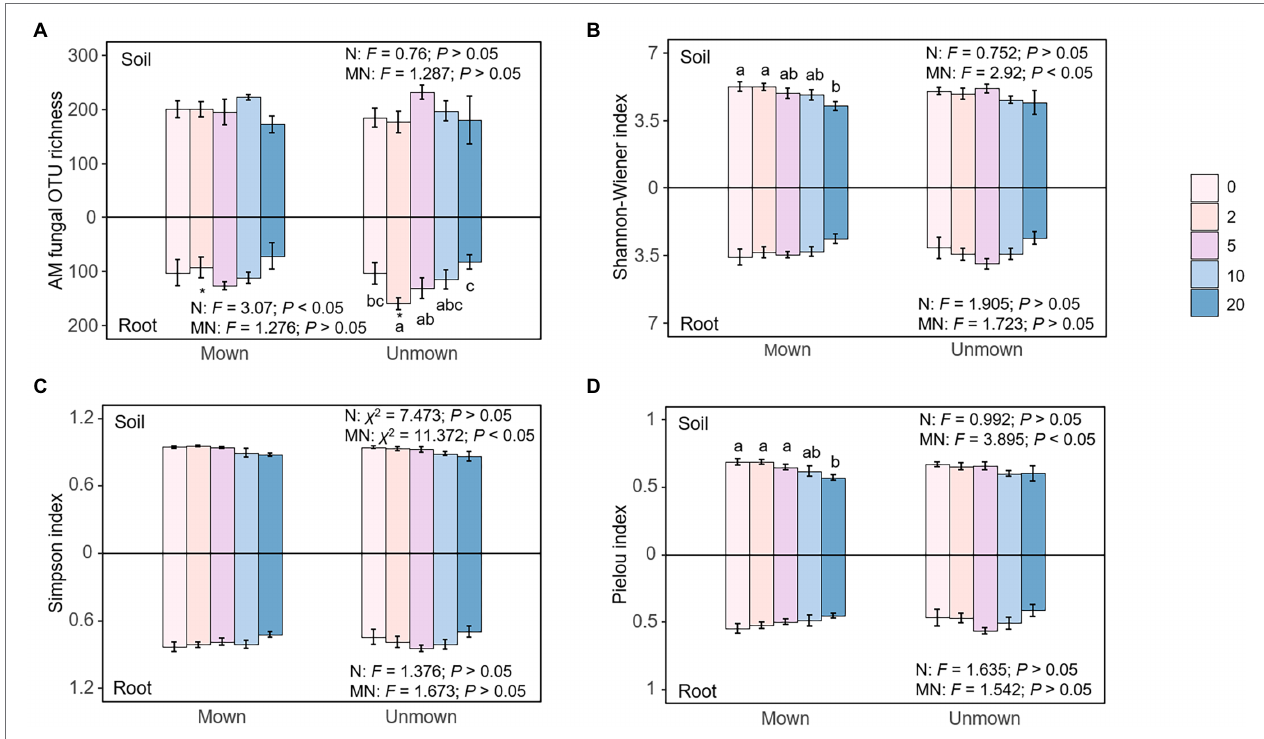
FIGURE 2 | Effects of nitrogen addition (N) and mowing (M) on AM fungal α -diversity in soil (upper) and roots (lower): (A) AM fungal operational taxonomic unit (OTU) richness, (B) AM fungal Shannon-Wiener index, (C) AM fungal Simpson index, (D) AM fungal Pielou index. All data are expressed as mean ± SE ( n = 5). One- way ANOVA, Tukey’s HSD, and t tests were used to test the effects of nitrogen addition and mowing on AM fungal α -diversity in the soil and roots in each nitrogen addition and mowing treatment. Different letters denote significant differences ( p < 0.05) among nitrogen addition rates in the mown and unmown treatments at soil or root. The symbol “*” at the top or bottom of the column indicates a significant difference ( p < 0.05) between mown and unmown at each nitrogen addition rate in soil or root. The numbers 0, 2, 5, 10, and 20 denote nitrogen addition with 0, 2, 5, 10, and 20 g m − 2 yr. − 1 , respectively.